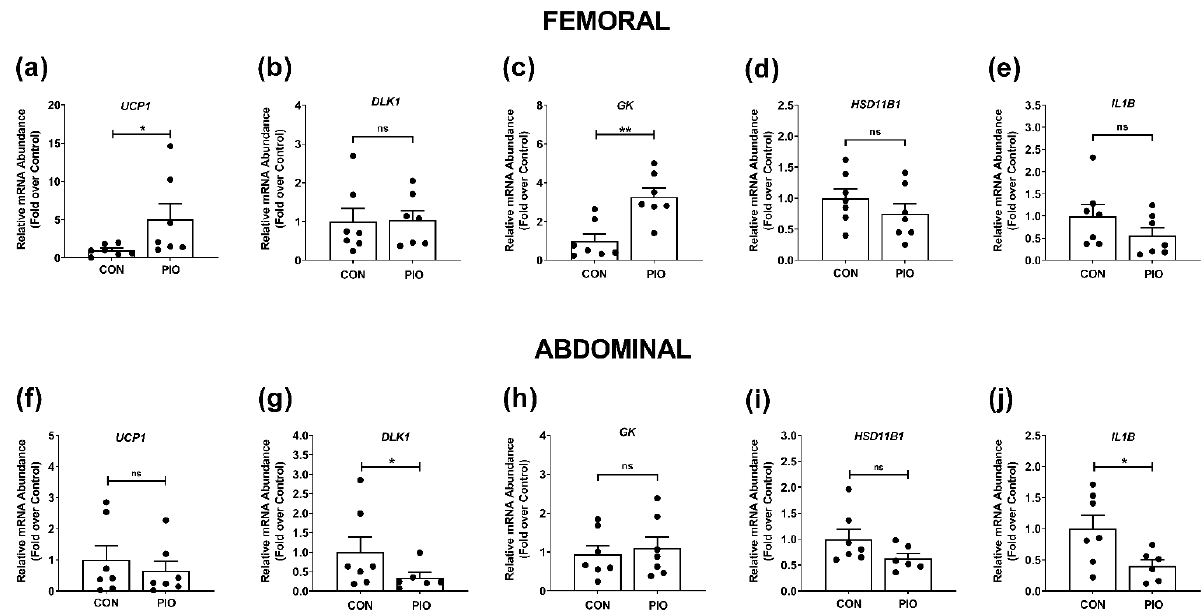
Figure 6. Pioglitazone reduces inflammation while also promoting markers of browning and fatty acid reesterification in white adipose tissue of human subjects. Relative mRNA abundance of ( a ) UCP1, ( b ) DLK1, ( c ) GK, ( d ) HSD11B1, and ( e ) IL1B in femoral adipose tissue from human subjects. Gene expression analysis of ( f ) UCP1, ( g ) DLK1, ( h ) GK, ( i ) HSD11B1, and ( j ) IL1B in abdominal adipose tissue from humans with the indicated conditions. n = 7 per group. Values are represented as the means ± SEM. * p < 0.05, ** p < 0.01. ns, not significant.